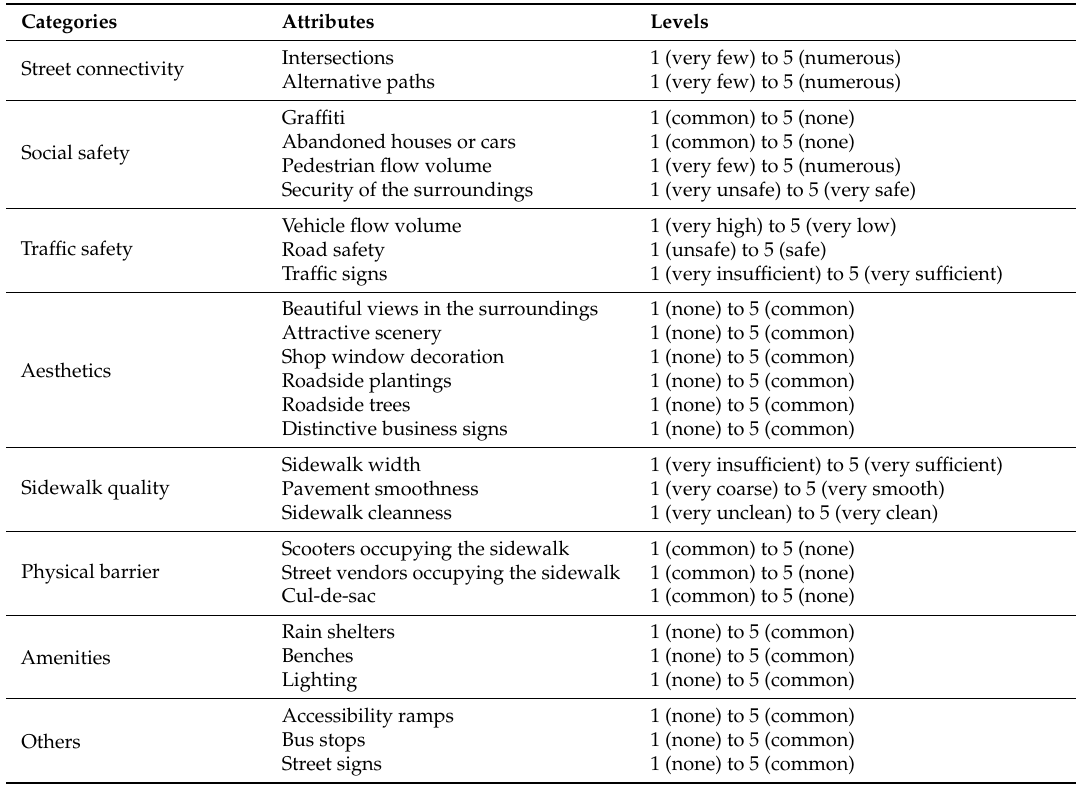
Table 1. Walkability measure